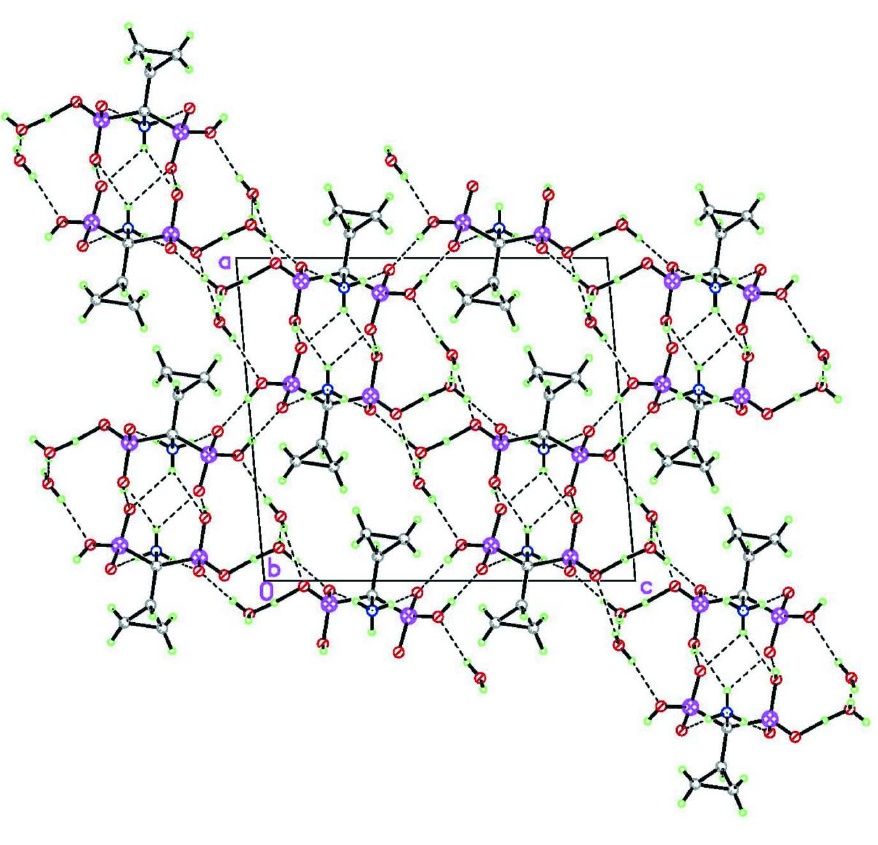
Figure 1 The asymmetric unit of title compound showing 50% probability displacement ellipsoids for the non-hydrogen